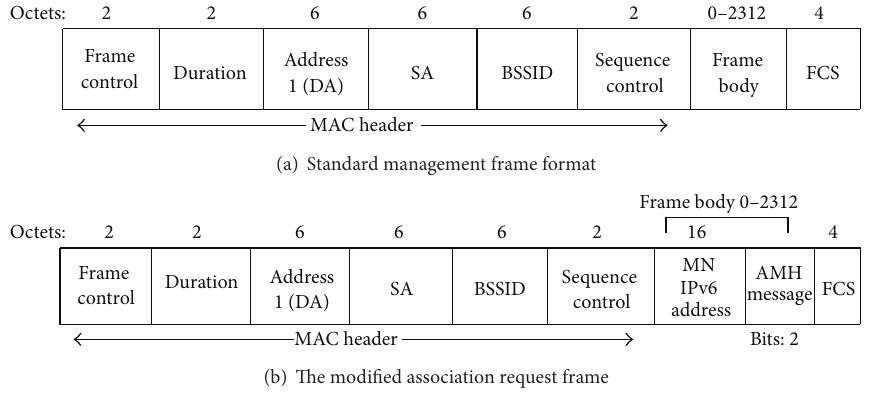
Figure 3: The management frame format and modified association request frame. Table 2: Data updating in each of AP and AR after AMH1 message.